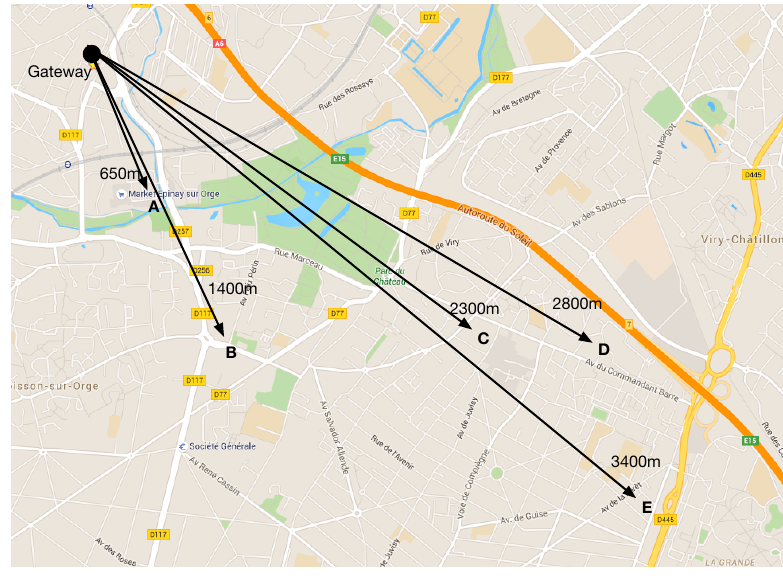
Figure 6. Map of LoRa field test.